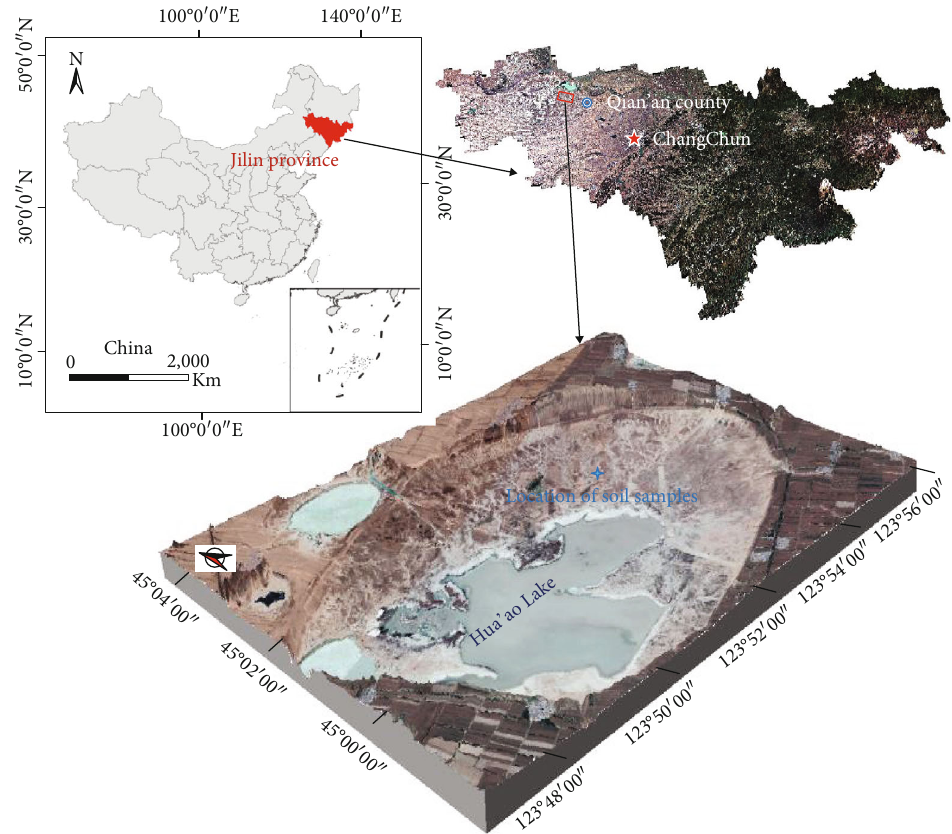
Figure 1: Location and topographical and geomorphic conditions of the study area.